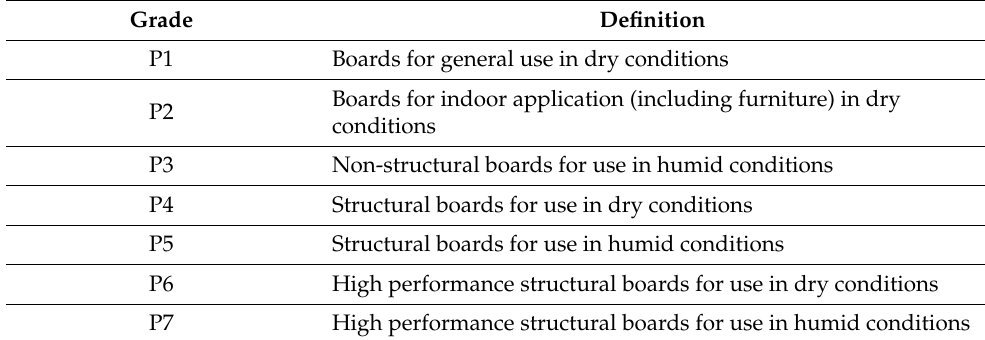
Table 5. Classification of experimental panels based on European Standards [68].